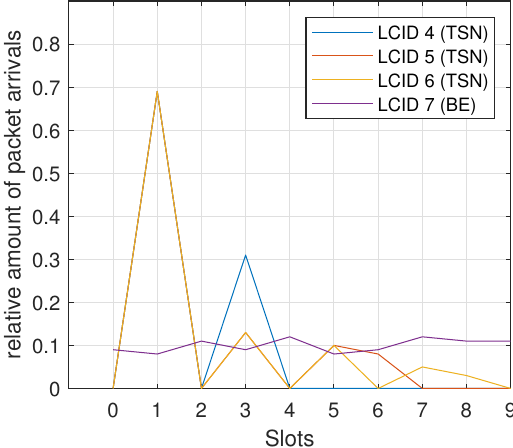
Figure 5. Density of arrival slots with static